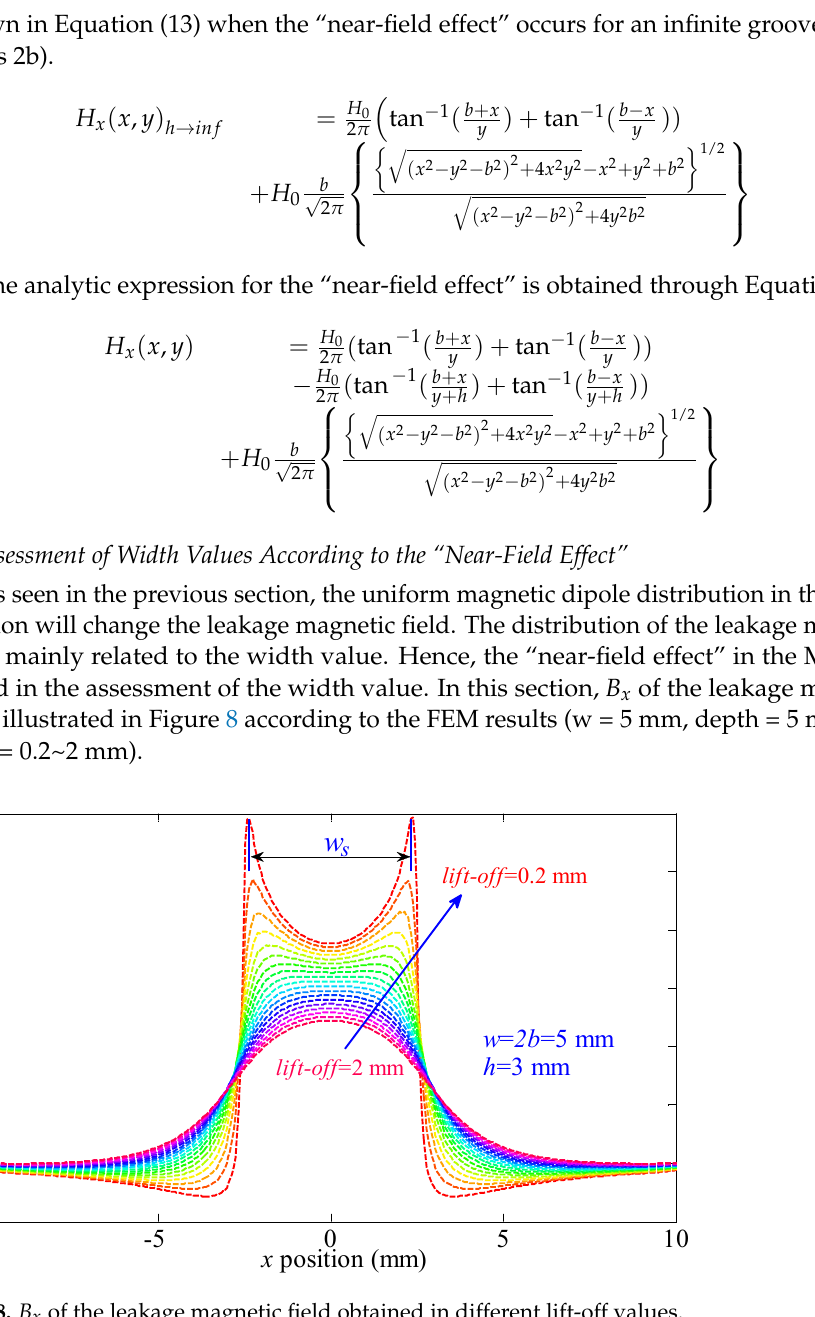
Figure 8. Bx of the leakage magnetic field obtained in different lift-off values. Figure 8. B x of the leakage magnetic field obtained in different lift-off